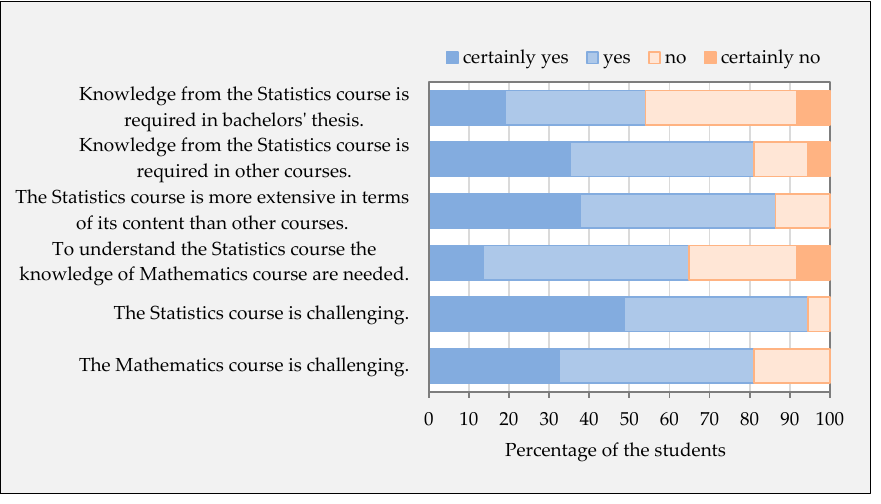
Figure 11. Evaluation of the difficulty of the Statistics course and application of the knowledge from it.